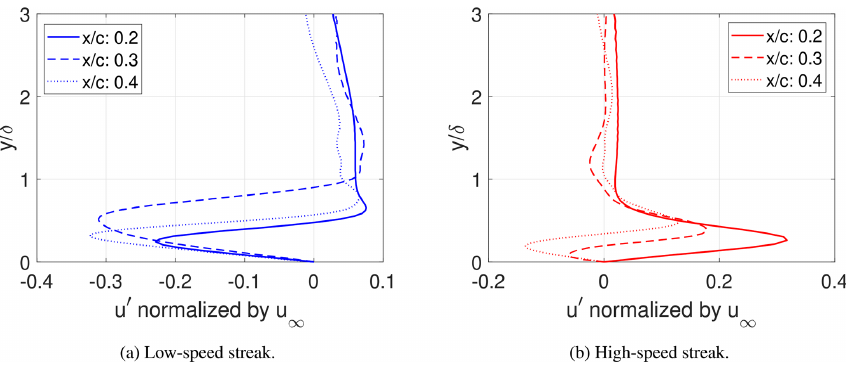
Figure 16. u (cid:48) streaks that lead to the formation of an inner instability at TI =